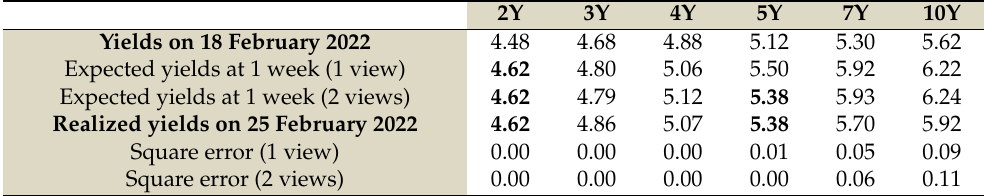
Table 10. Weekly yield curve forecasts incorporating the trader’s views on 18 February 2022 and realized yields on 25 February 2022. Source: Bloomberg, own computation.